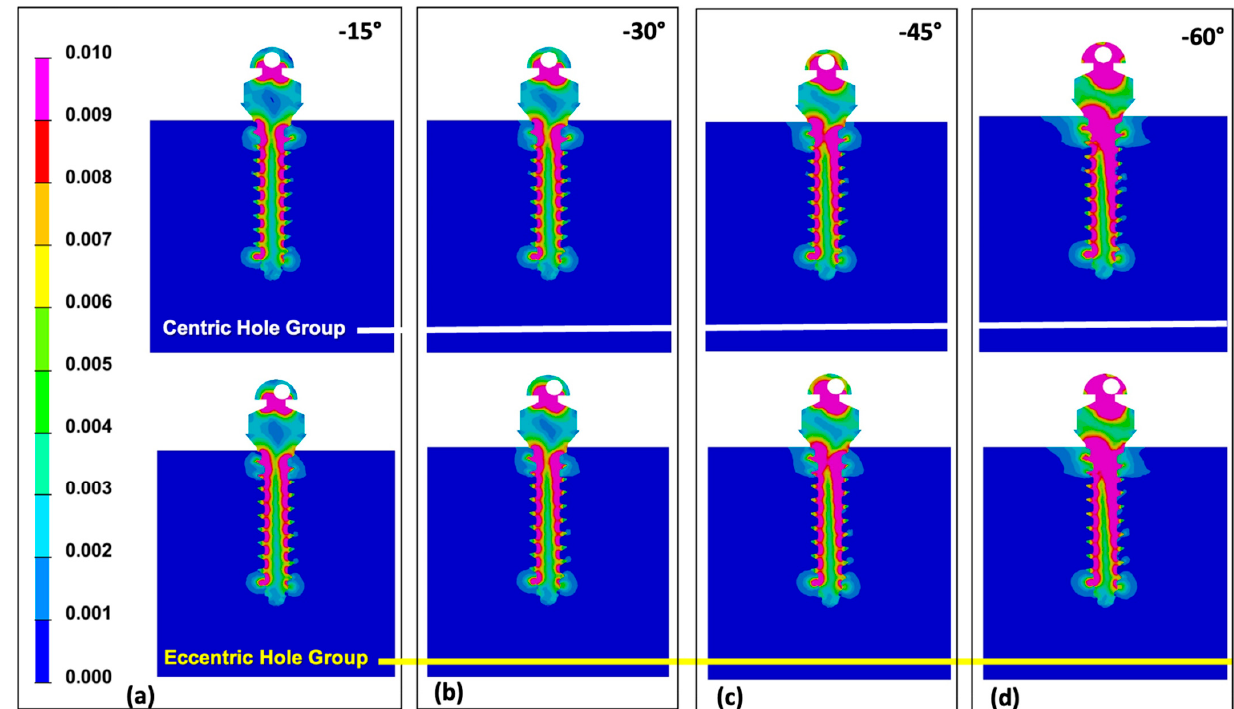
Figure 6. Distribution of maximum Von-Mises stress under the condition of 1 ° counter-clockwise rotation of the miniscrew placed with various negative angles on the alveolar bone surface: ( a ) Von-Mises stress distribution of the miniscrew at − 15 ° angulation in centric and eccentric hole groups; ( b ) Von-Mises stress distribution of the miniscrew at − 30 ° angulation in centric and eccentric hole groups; ( c ) Von-Mises stress distribution of the miniscrew at − 45 ° angulation in centric and eccentric hole groups; ( d ) Von-Mises stress distribution of the miniscrew at -60 ° angulation in centric and eccentric hole groups. In both groups, more stress was concentrated on the upper 1/3 as the angle increased, and the stress distribution tendency was opposite to the result of the miniscrews implanted at positive angles.